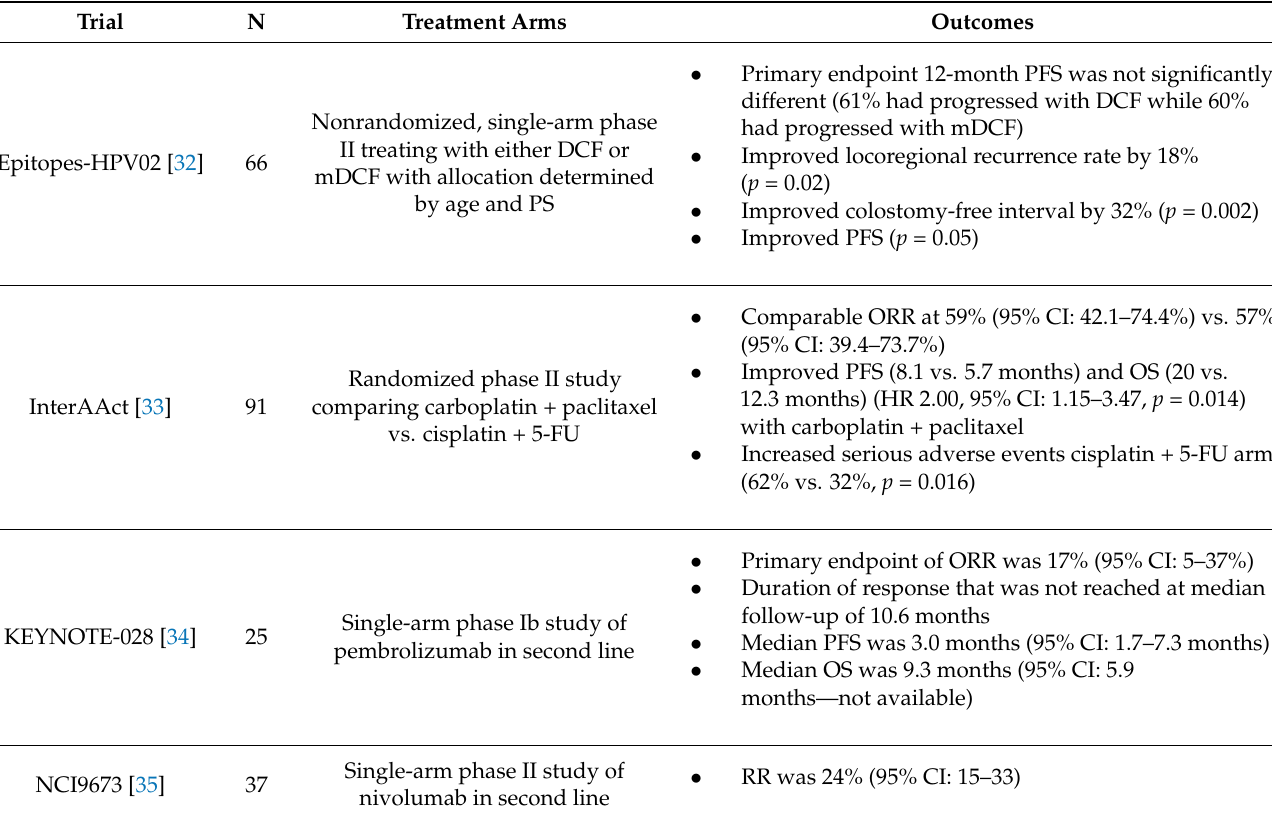
Table 2. Landmark Studies in Management of Metastatic